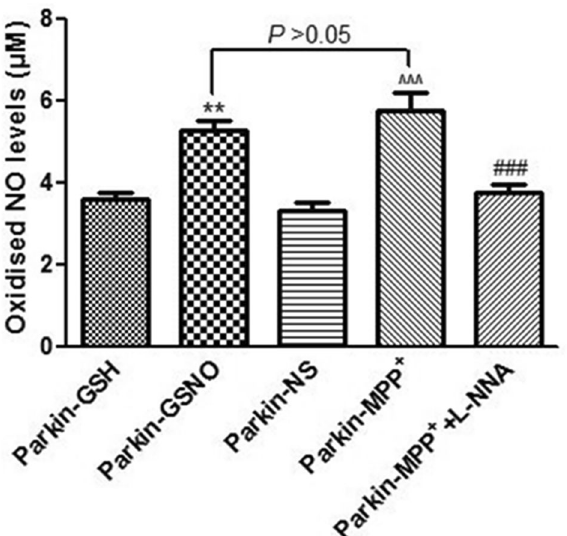
Figure 3. GSNO and MPP + increased NO generation in parkin-transfected SH-SY5Y cells. Changes of oxidized NO levels following different treatment (200 μM of MPP + ; 200 μM of GSNO; 200 μM of GSNO + 1 mM of L-NNA) for 24 h in parkin-transfected SH-SY5Y cells. ** P = 0.004, parkin-GSNO versus parkin-GSH; ^^^ P = 0.0007, parkin-MPP + versus parkin-NS; ### P = 0.0009, parkin-MPP + + L-NNA versus parkin-MPP + .